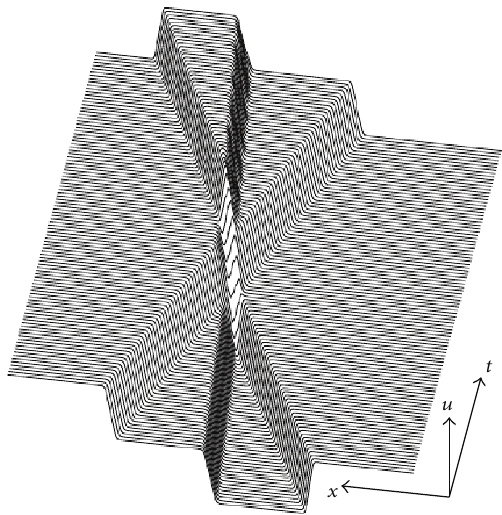
Figure 4: Evolution of the kink-kink-antikink triplet, 𝑉 1 > 0 , 𝑉 2 < < 0 . 0 , 𝑉 3